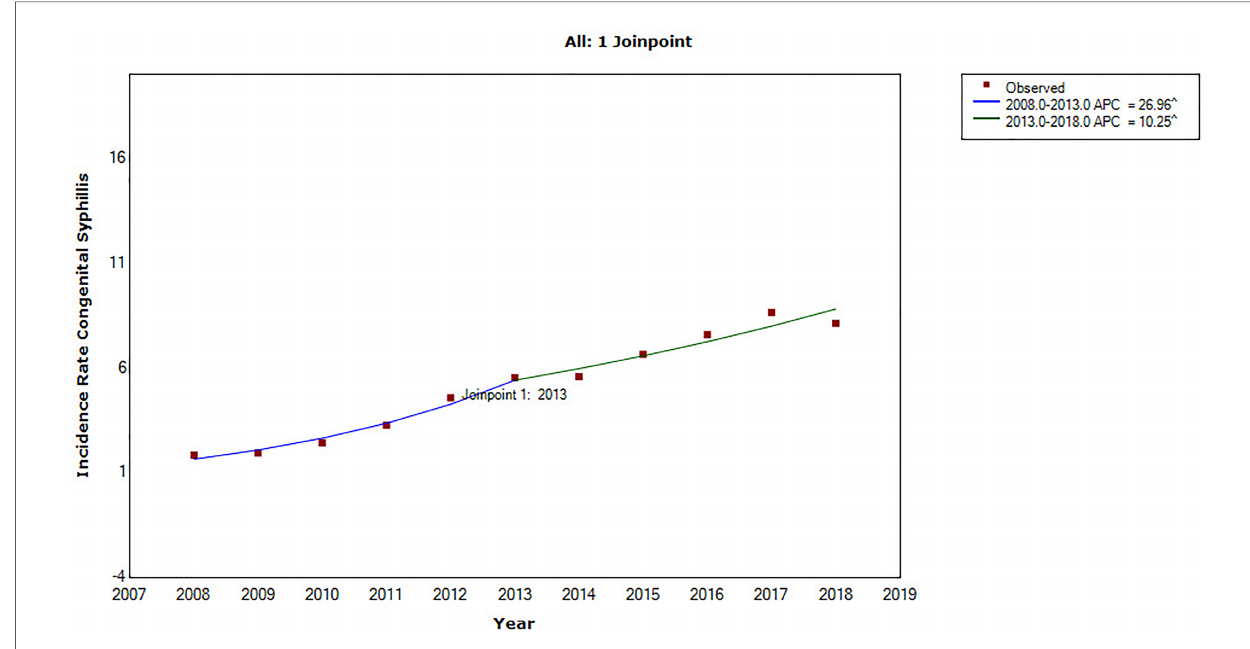
FIGURE 1 Time series of the incidence rate of congenital syphilis (dots) in Brazil from 2008 to 2018, according to the fi nal selected model: 1 joinpoint. ^Indicates that the annual percent change (APC) is signi fi cantly different from zero at the alpha=0.05 level.